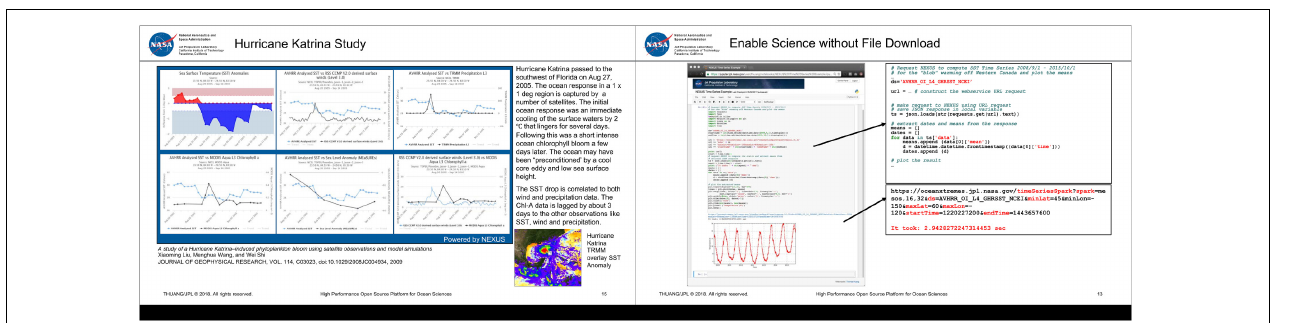
FIGURE 2 | Example oceanworks